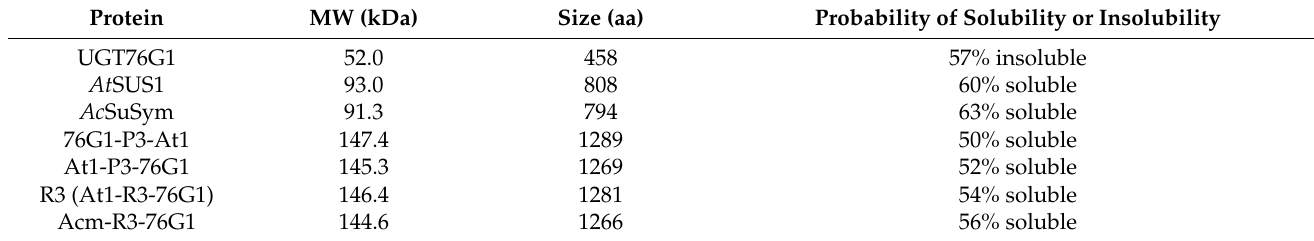
Table 5. Prediction of the solubility of